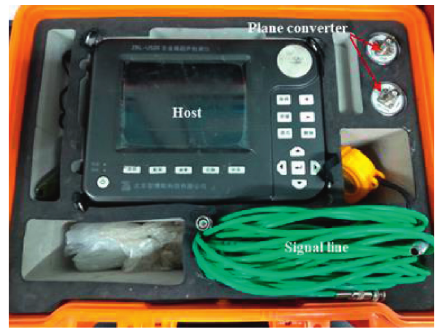
Figure 2: ZBL-U520 nonmetal ultrasonic detector.